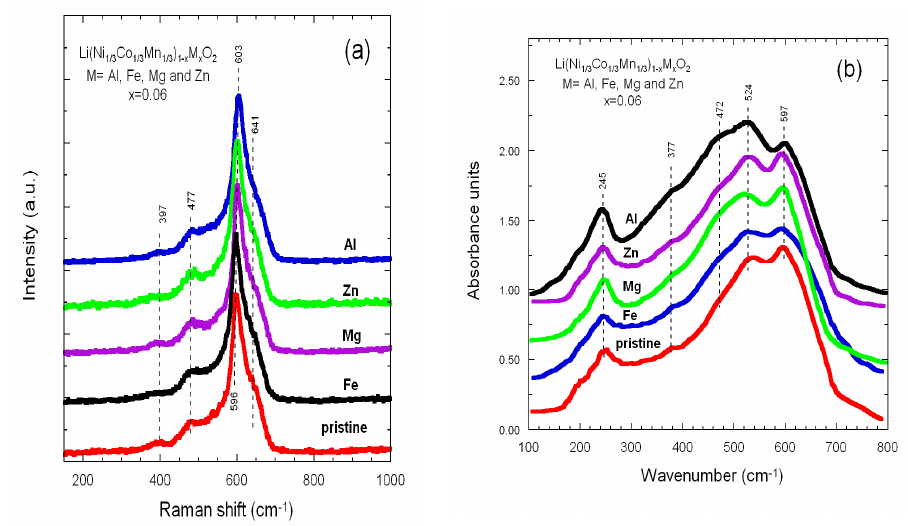
Figure 5. ( a ) Raman spectra and ( b ) FTIR of undoped and doped LiNi 1 / 3 Mn 1 / 3 Co 1 / 3 O 2 ( x = 0.06) powders synthesized via sol-gel method.